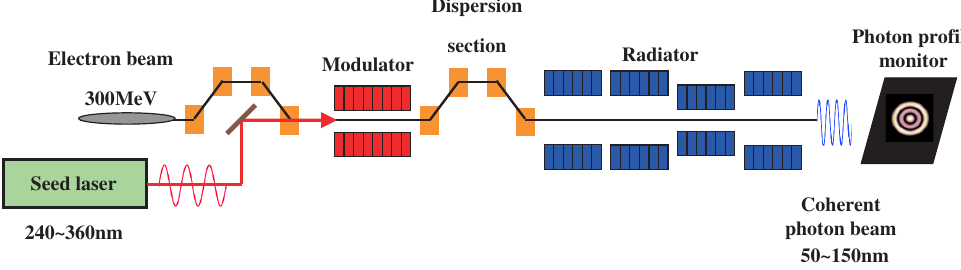
FIG. 1. Schematic of a seeded extreme ultraviolet